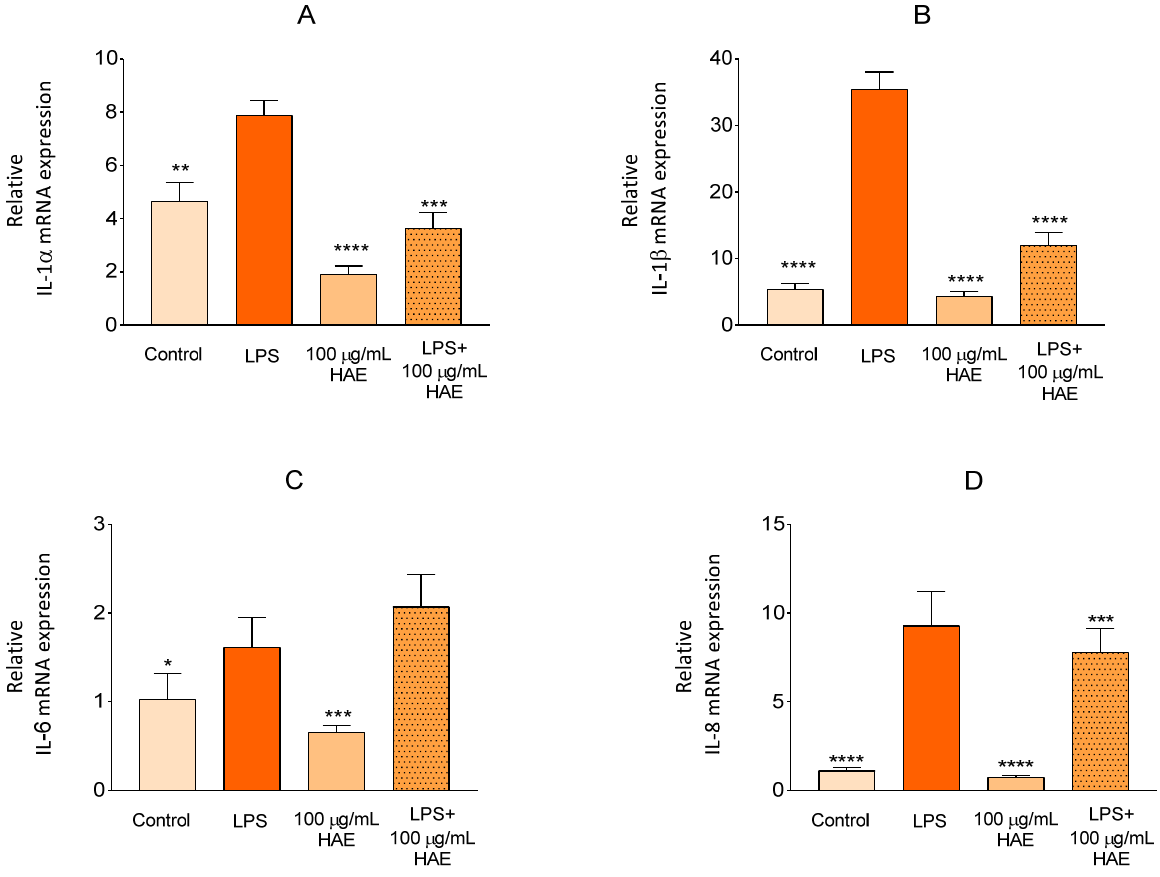
Figure 7. The anti-inflammatory action of HAE. qPCR analyses of gene expression of IL-1 α ( A ), IL-1 β ( B ), IL-6 ( C ) and IL-8 ( D ) on HUVECs following the indicated 24 h of simultaneous treatment. Total RNA was isolated by using Extrazole. Reverse transcription was performed in a Life ECO Thermal Cycler by using an UltraScript 2.0 cDNA Synthesis Kit. The cDNA was amplified by using the 2 × qPCRBIO Probe Mix No-ROX assay. Data are presented by using the ∆∆ CT method regarding glyceraldehyde-3-phosphate dehydrogenase (GAPDH)-normalized mRNA expressions of the untreated control. *, **, *** and **** mark significance ( p < 0.05, p < 0.005, p < 0.0005 and p < 0.0001).